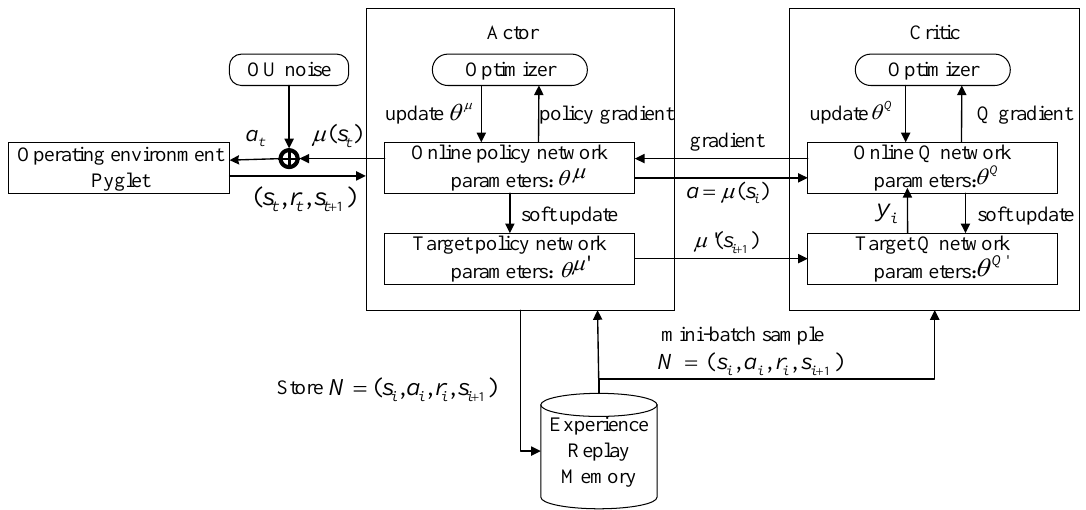
Figure 4. DDPG algorithm flow chart. OU—Ornstein–Uhlenbeck process.